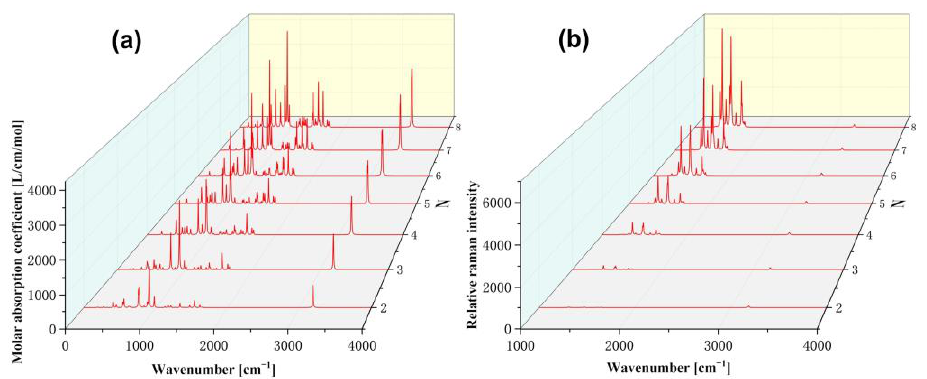
Figure 8. IR spectra ( a ) and Raman spectra ( b ) of [2N, 2N]CNB. The peaks of the infrared and Raman spectra are broadened by the Lorentz function, FWHM = 8.0 cm −1.